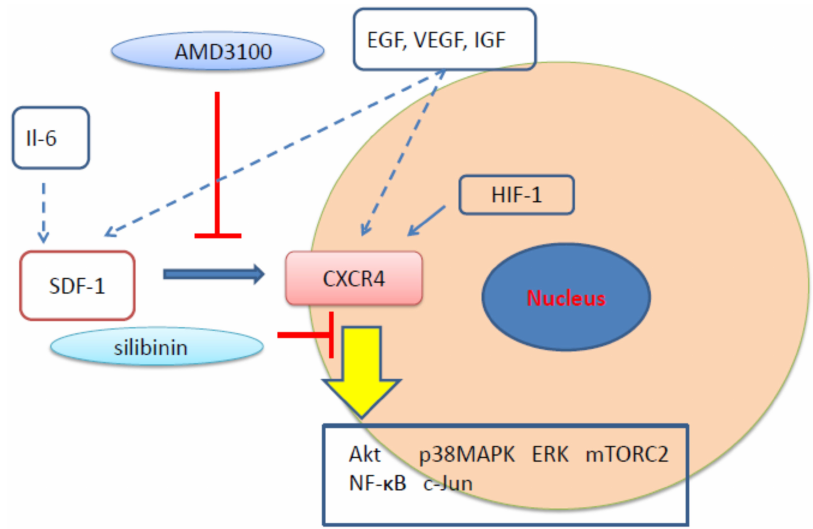
Figure 1. The sites of signal transduction for CXC motif chemokine receptor type 4 (CXCR4)